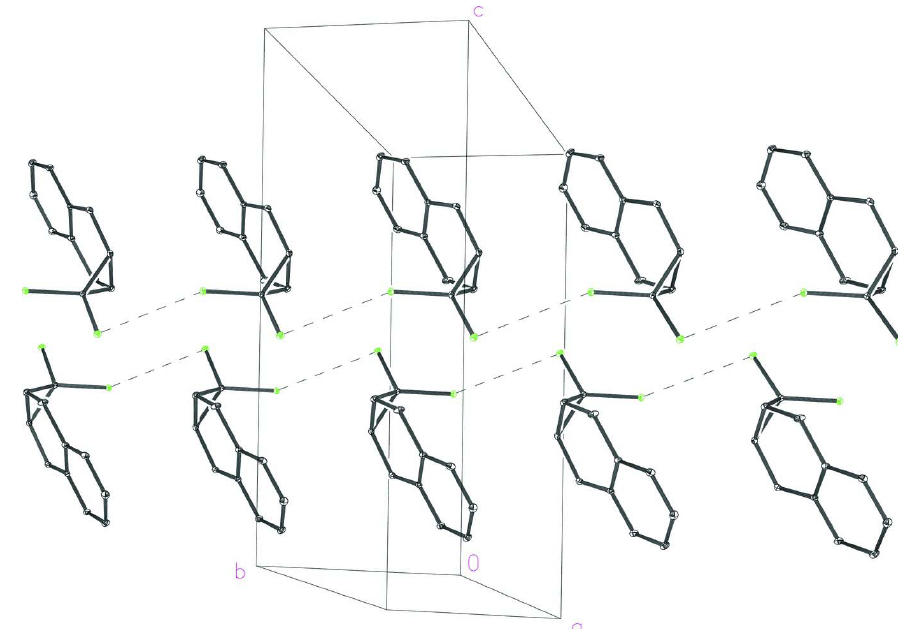
Figure 2 Partial packing view of ( I ) showing Cl···Cl interaction. H atoms have been omitted for